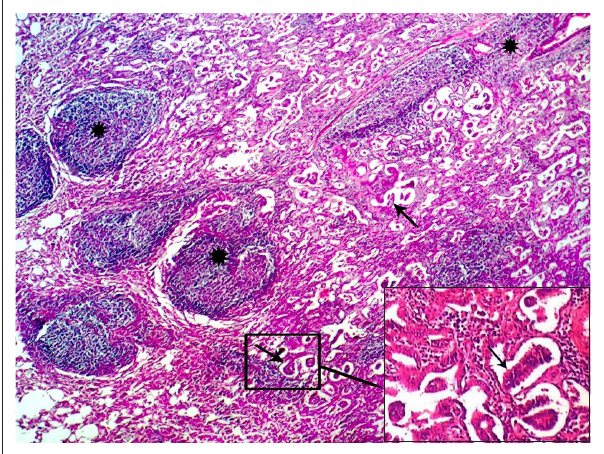
FIGURE 3: Marked perivascular and peribronchiolar lymphoid hyperplasia typical of maedi (asterisks) associated with the lesions of pulmonary adenomatosis (thin arrows) (H&E, ×100). Note: Lesions are shown at higher magnification in the bottom right hand corner of the figure